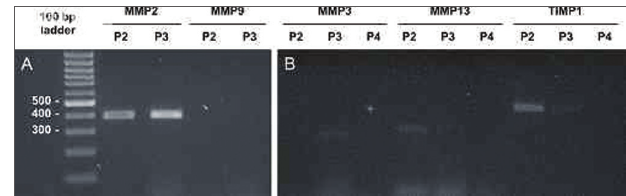
Figura 2. Amplificação de isoformas de MMPs e TIMPs para amostras selecionadas. Análise por eletroforese em gel de agarose 2% corado por brometo de etídio. Padrão de peso molecular = 100 bp ladder. (A) MMP-2 e MMP-9 para as amostras P2 e P3. (B) MMP-3, MMP-13 e TIMP-1 para as amostras P2, P3 e